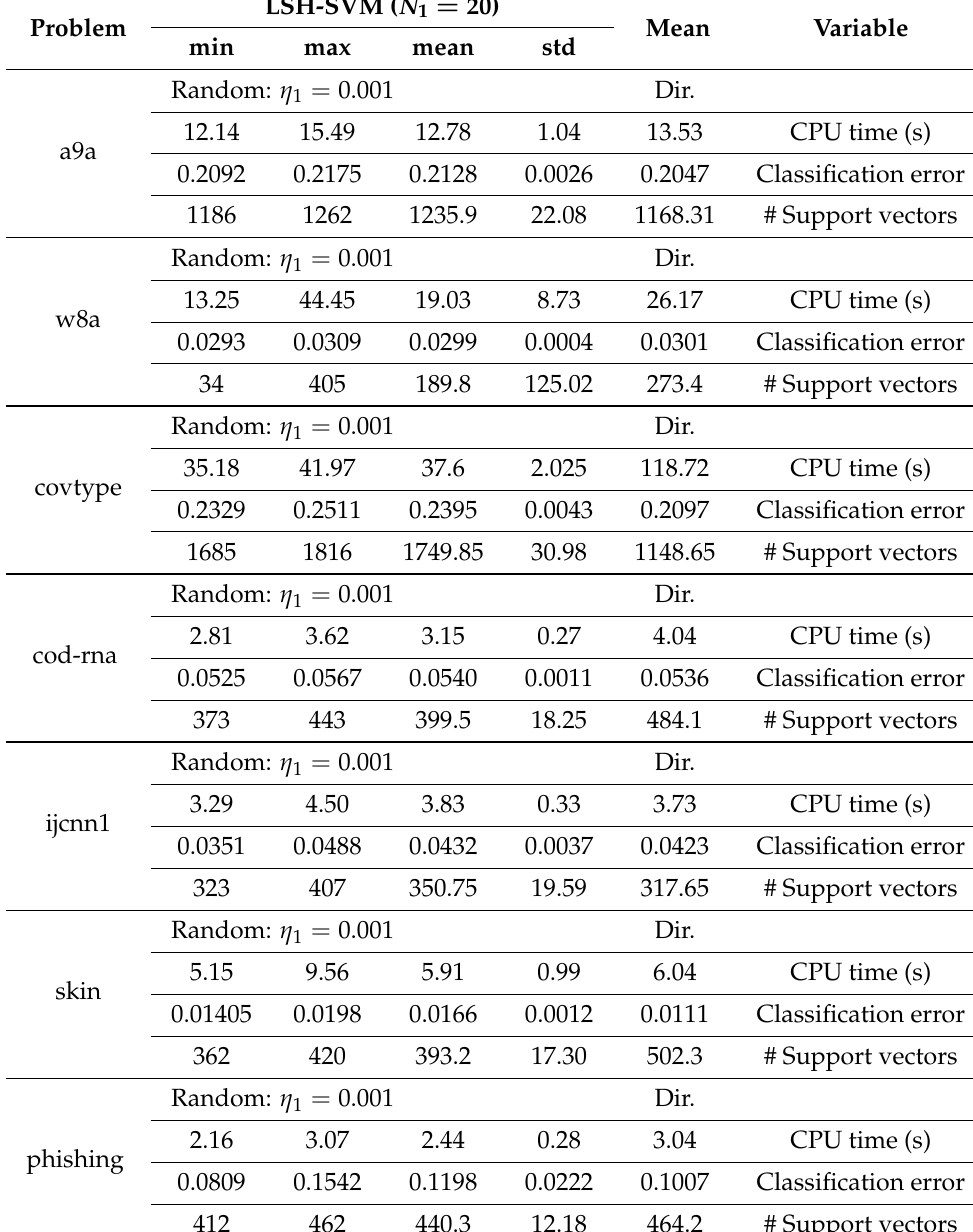
Table 5. LSH-SVM Algorithm 1: random vs. Algorithm 2: directed